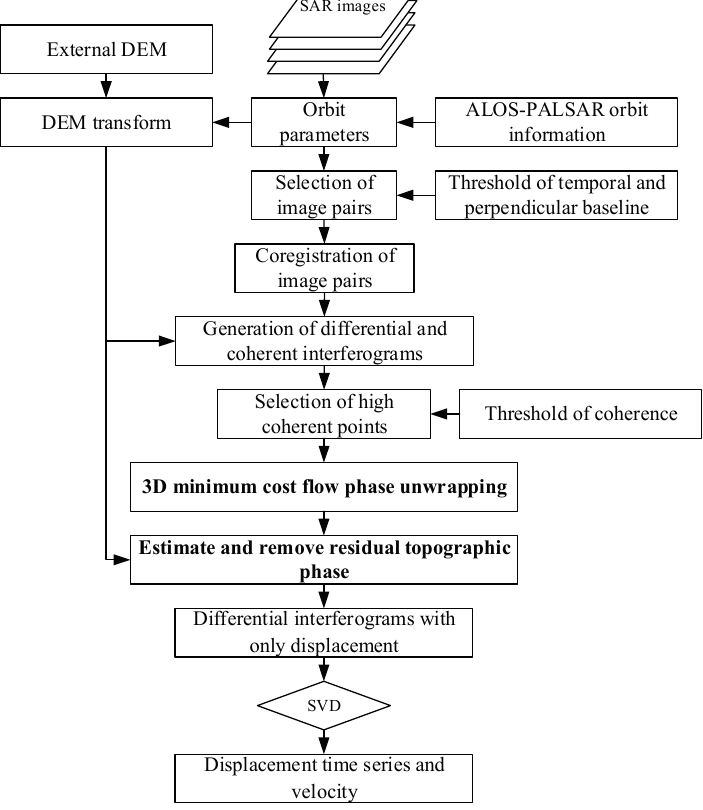
Figure 3. Flowchart of the differential synthetic aperture radar interferometry based small baseline subset (DInSAR-SBAS)